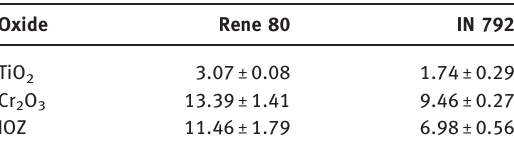
Table 2: Measured thicknesses ( μ m) of oxide scale layers in outer scale and width of zone containing internal Al-oxide (IOZ).